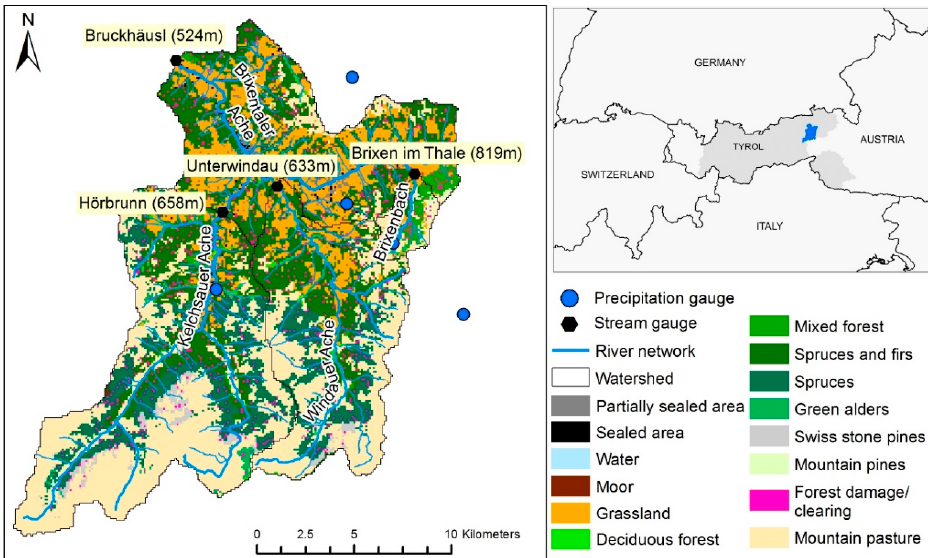
Figure 1. Location of the study area based on data of land use [29] and forest composition [30], with network of meteorological and hydrological stations, operated by the Hydrographic Service of Tyrol.